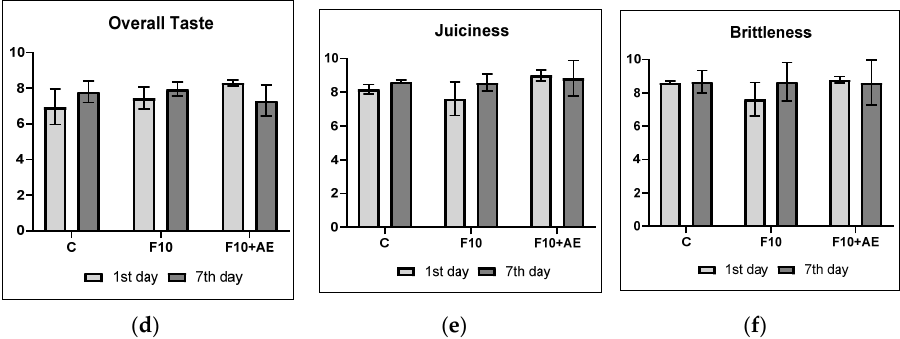
Figure 3. The results of sensory evaluation of thigh meat samples (means ± SD): ( a ) overall acceptability, ( b ) overall appearance, ( c ) overall aroma, ( d ) overall taste, ( e ) juiciness and ( f ) brittleness. C: control group; FF10: broilers fed with a diet enriched with supplementation of 10% FF; FF10 + AE: broilers fed with a diet enriched with 10% supplementation of FF supported with 0.2% agrimony extract.